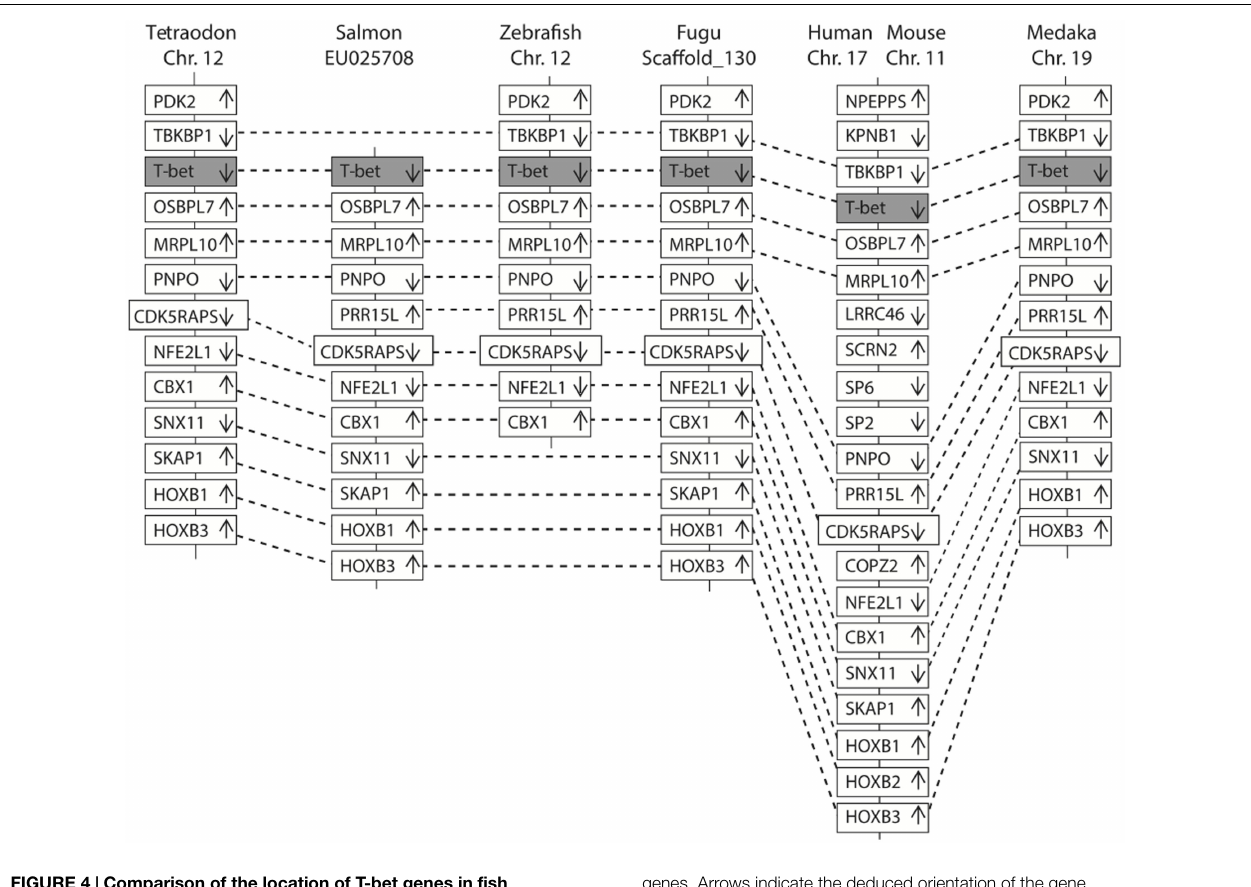
FIGURE 4 | Comparison of the location of T-bet genes in fish and mammals . The chromosomes and scaffold were identified in ENSEMBL (http://www.ensembl.org/). Boxes represent the deduced